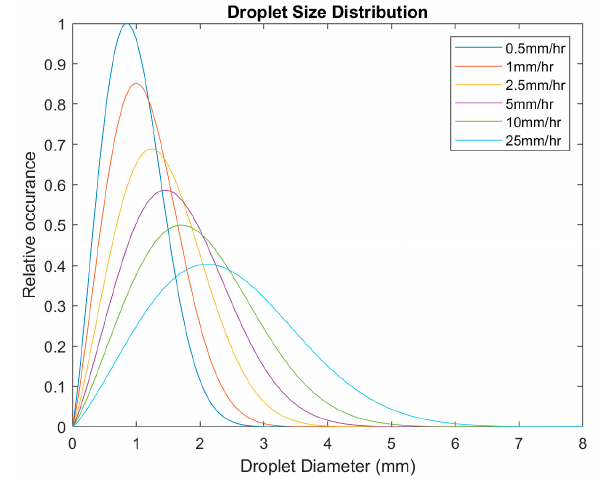
Figure 5. Droplet size distribution for different rainfall intensities, produced using the Best